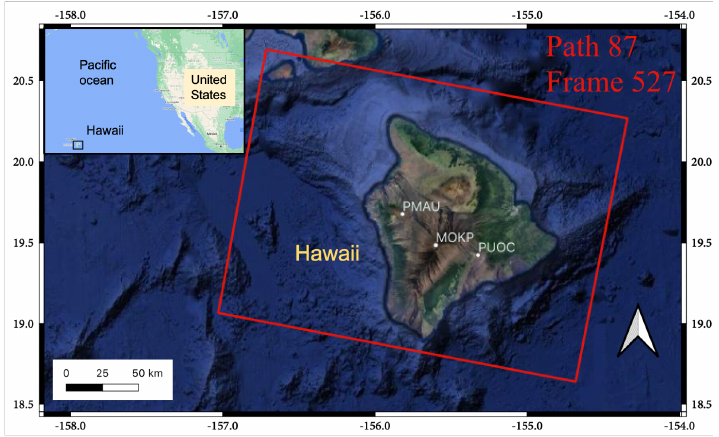
Figure 2. Coverage of the descending frame of Path 87, Frame 527. White markers show the locations of permanent GNSS stations that we used in this